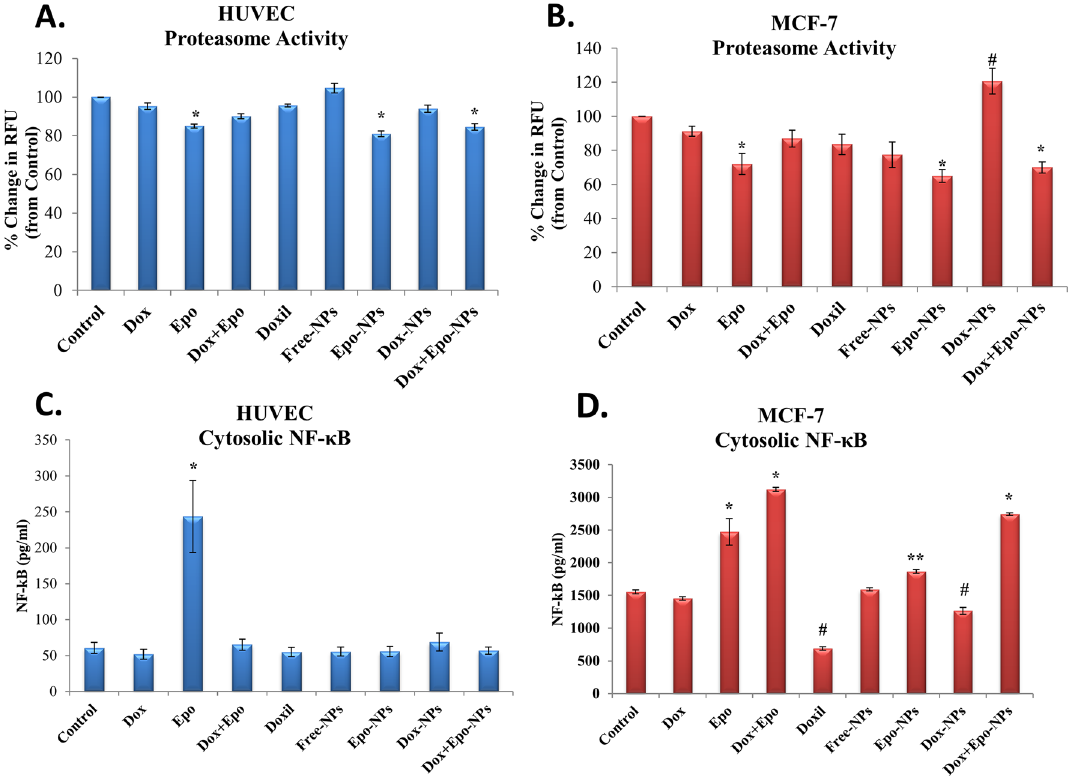
Figure 6. (A) Proteasome Activity in the nine HUVECs groups incubated for 24 h (n = 3 in each experiment). Values are mean ± SD. ( B) Proteasome Activity in the nine MCF-7 cell groups incubated for 24 h (n = 3 in each experiment). Values are mean ± SD. *Values significantly different from the control, free Dox, free Dox + Epo, DOXIL, Free-NPs, and Dox-NPs in the HUVECs and MCF-7 cells p < 0.01. # Values significantly different from control, free Dox, in the MCF-7 cells p < 0.001. ( C) Cytosolic NF-κB levels in the nine HUVECs groups incubated for 24 h (n = 3 in each experiment). Values are mean ± SD. *Values significantly different from all groups in the HUVECs p < 0.001. ( D) Cytosolic NF-κB levels in the nine MCF-7 cell groups incubated for 24 h (n = 3 in each experiment). Values are mean ± SD. *Values significantly different from control, free Dox, DOXIL, Free-NPs, Epo-NPs, and Dox-NPs groups in the MCF-7 cells p < 0.001. **Values significantly different from control, free Dox, DOXIL, and Free-NPs groups in the MCF-7 cells p < 0.01. # Values significantly different from control, free Dox, and DOXIL groups in the MCF-7 cells p <